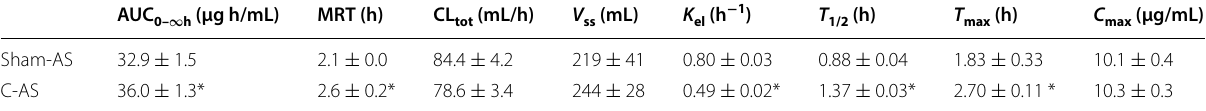
Values are presented as the mean SEM ( n 3–6) ± = AUC area under the concentration–time curve, MRT mean residence time, CL tot total body clearance, V ss steady-state volume of distribution, K el elimination rate constant, T 1/2 biological half-life, T max time to maximum drug concentration, C max maximum drug concentration, AS astragaloside-IV, CS crush syndrome * p < 0.05 versus sham-AS group analyzed by Student’s t